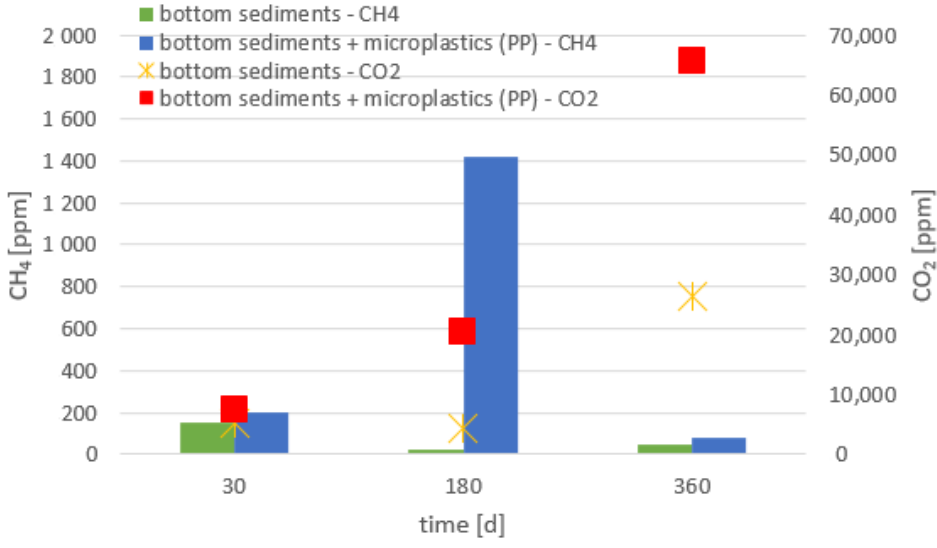
Figure 4. CH 4 and CO 2 emissions from